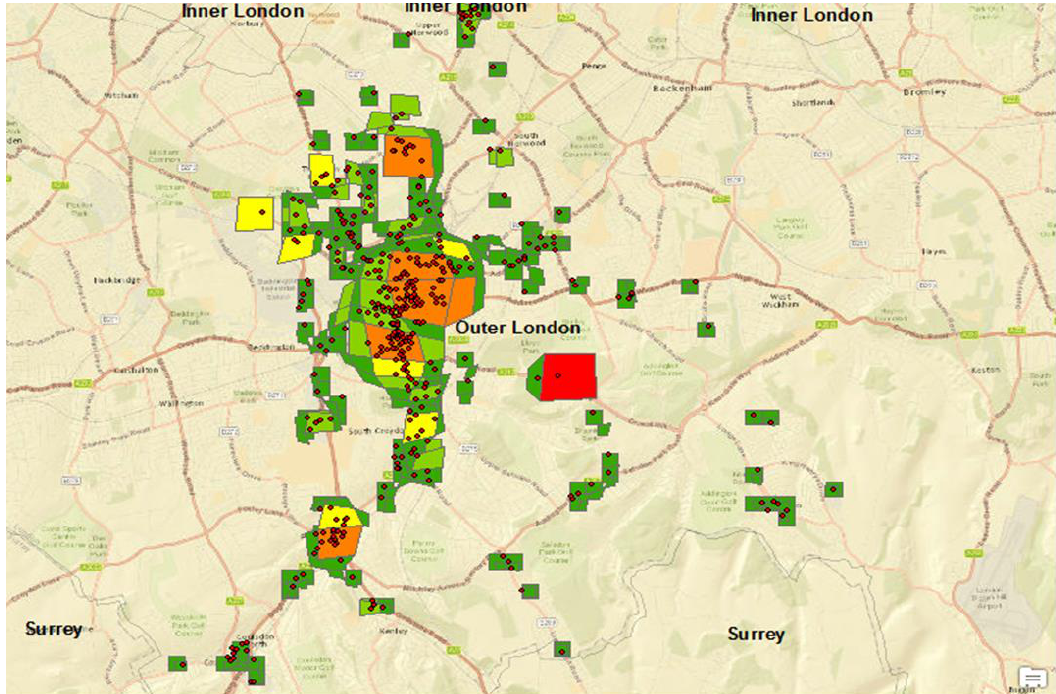
Figure 2. Relative scaling in